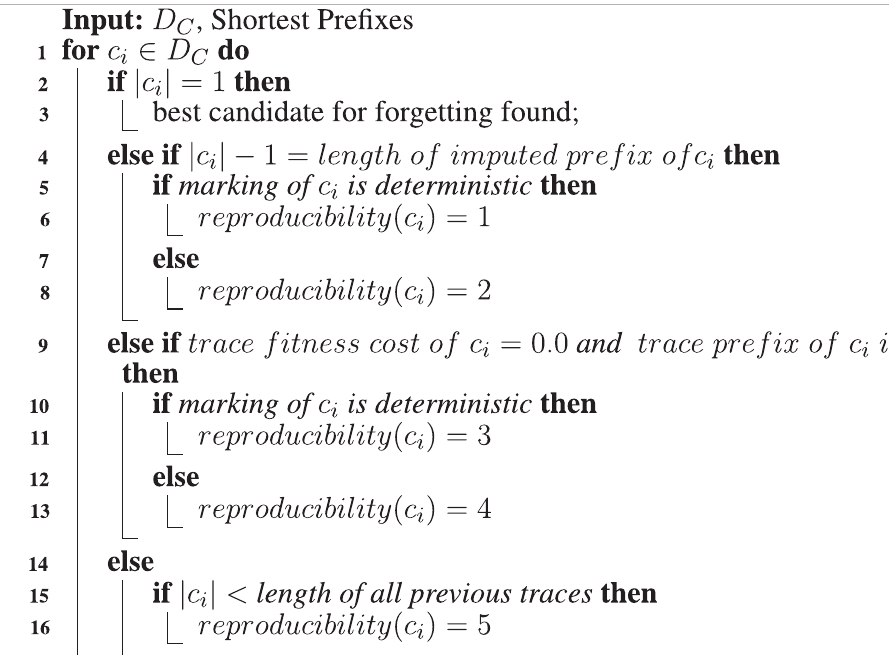
Algorithm 2 | Searching suitable cases for